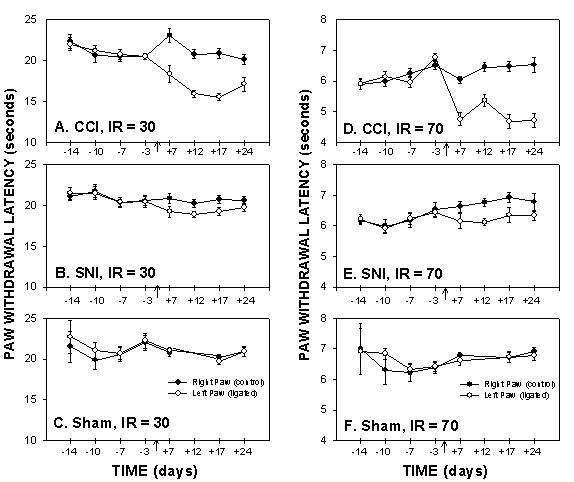
Plantar test for thermal sensitivity, paw-withdrawal latencies, as a function of time in CCI, SNI and sham rats, performed at 2 Infra Red (IR) intensities, 30 (A, B, and C) and 70 (D, E, and F). Paw withdrawal latencies of the ligated paw decreased in CCI and SNI rats 7 days post ligation as compared to the control (right) paw and to sham animals. Thermal hyperalgesia, as assessed on plantar test, was smaller in SNI than CCI rats.